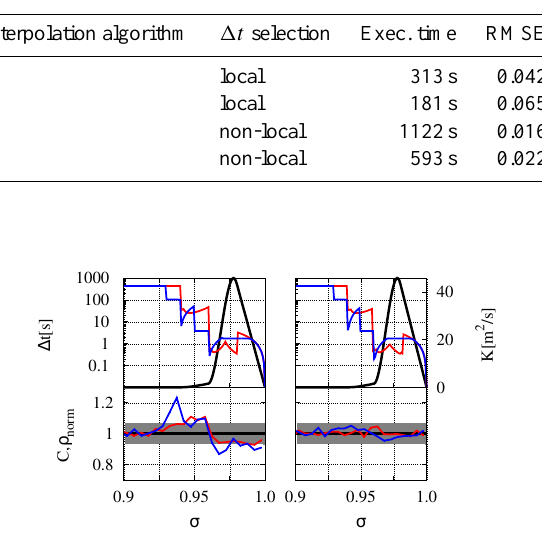
Figure 8. Same as in Fig. 7 for experiments with the “peaked” dif- Fig. 8. Same as in Fig. 7 for experiments with the ‘peaked’ diffusiv- fusivity distribution. Results obtained using the local (left) or non- ity distribution. Results obtained using the local (left) or non-local local (right) 1t selection (right) ∆ t selection algorithm.